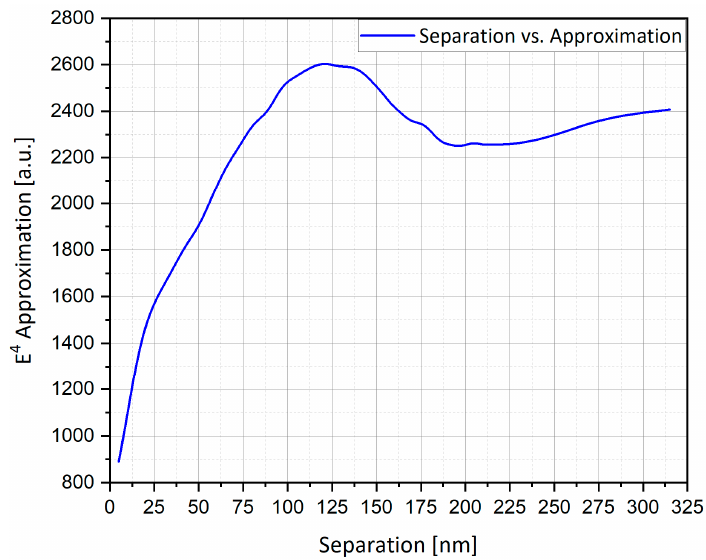
Figure 20. Enhancement vs. separation, for four silver hemi-spheroid in a plane wave, polarized orthogonally to axis of separation. Suppression is observed at short distances. At ~ 110 nm, the radiation field dominates the localized surface plasmon (LSP) (near) field.